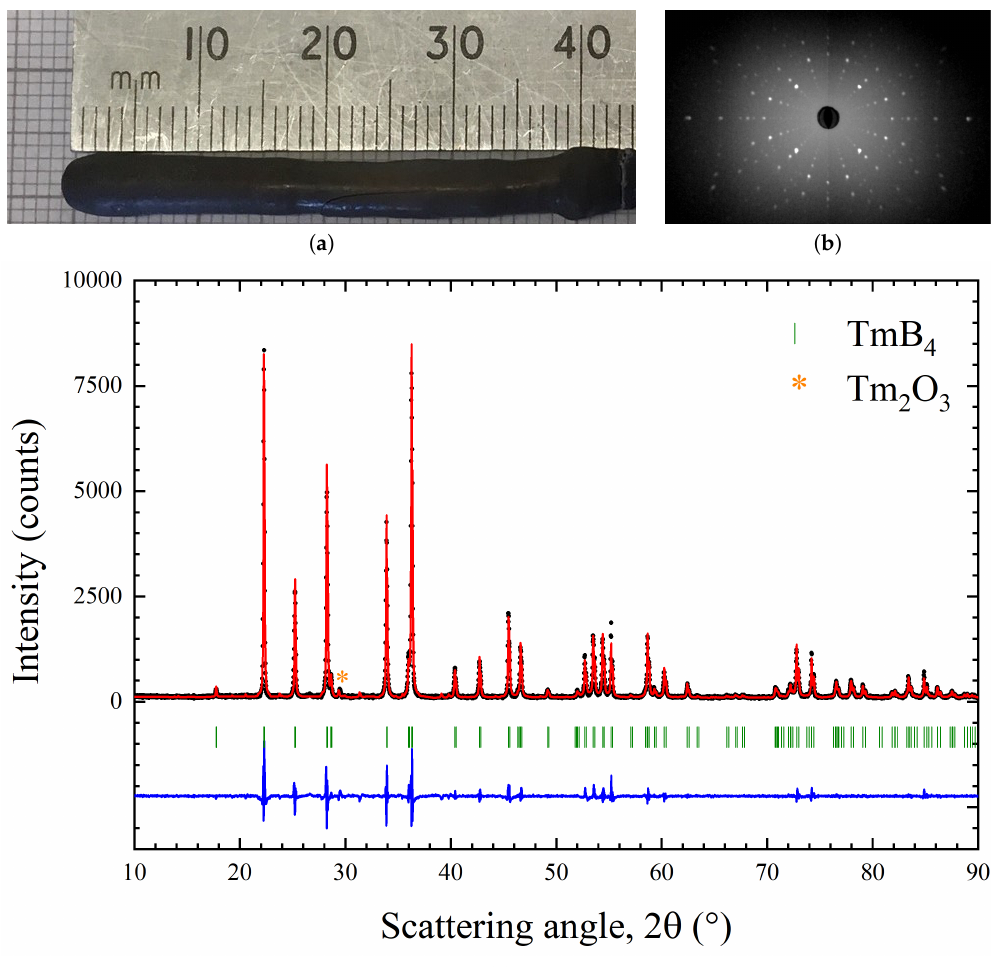
Figure 11. ( a ) Boule of TmB 4 prepared by the floating-zone method in an argon atmosphere at a growth rate of 18 mm/h. ( b ) X-ray Laue back reflection photograph of a crystal of TmB 4 , showing the [001] orientation of an aligned sample used for physical properties measurements. ( c ) Room temperature powder X-ray diffraction pattern of a ground TmB 4 crystal. The experimental profile (black closed circles) and a full profile matching refinement (red solid line) made using the P 4/ mbm tetragonal structure are shown, with the difference given by the blue solid line. The symbols * indicate the reflections belonging to a Tm 2 O 3